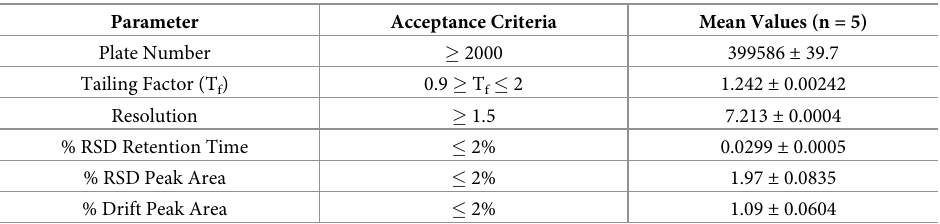
Table 3. System suitability